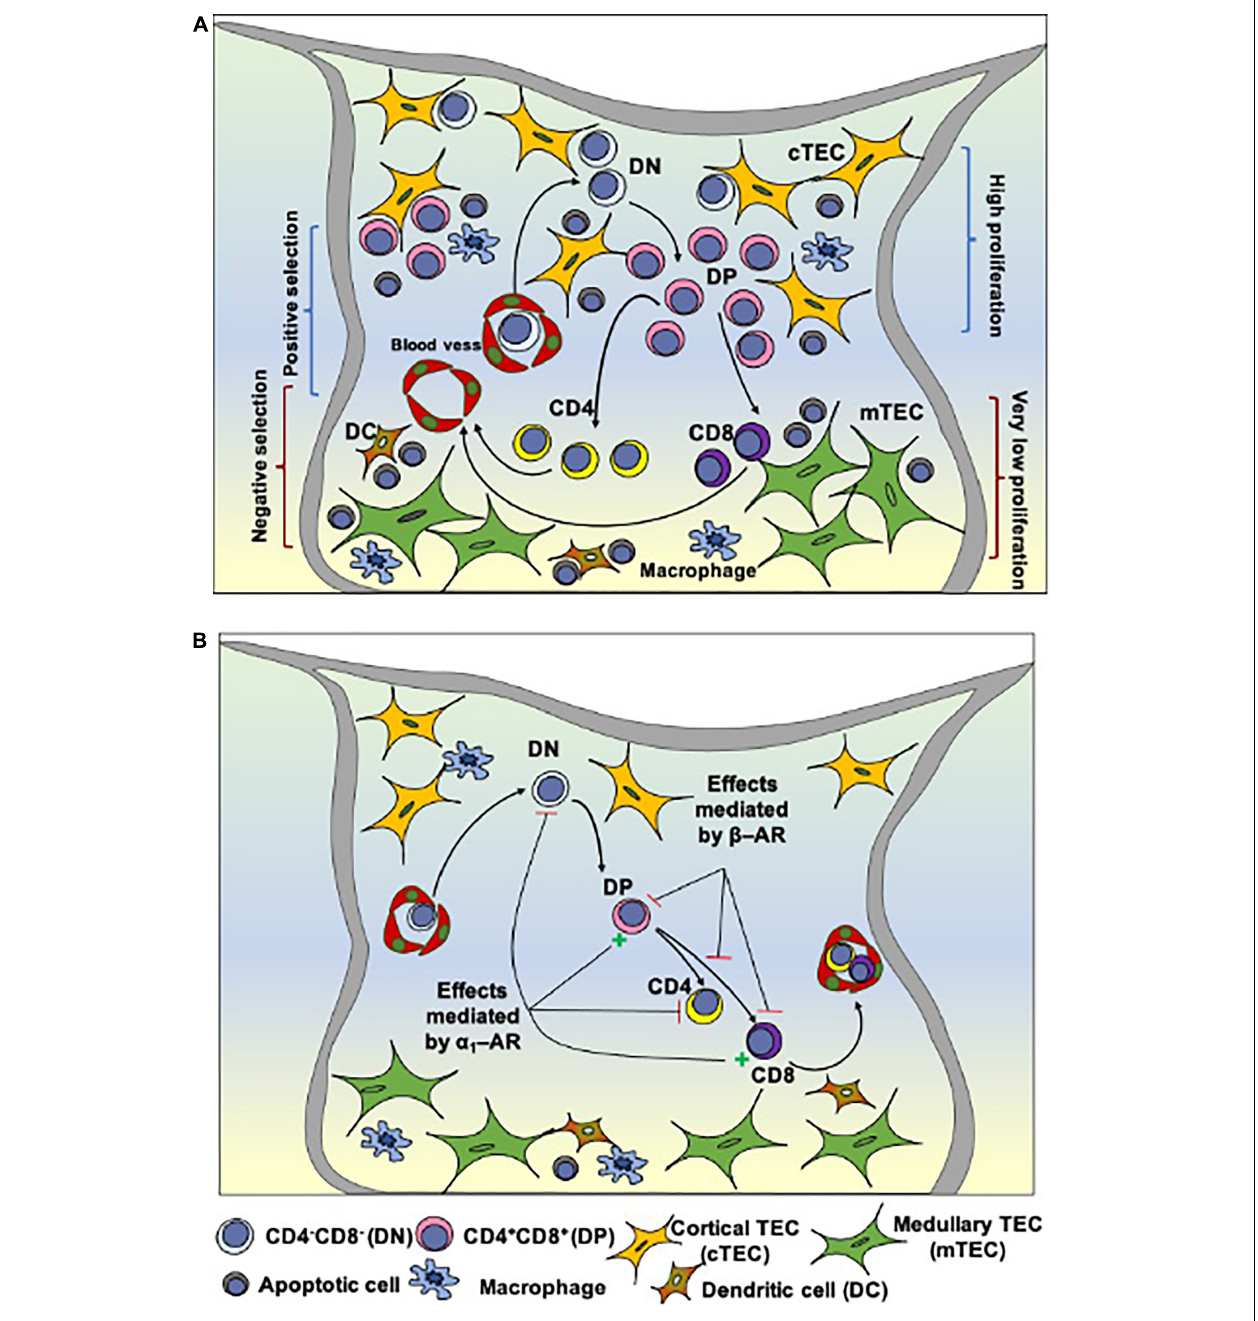
FIGURE 1 | Intrathymic T cell differentiation within the thymic microenvironment and stages that can be modulated by norepinephrine. (A) Shows schematically the general process of thymocyte differentiation, in the context of the thymic microenvironment. Bone marrow-derived precursors enter the organ through capillaries at the corticomedullary junction and migrate toward the outer cortex where they proliferate, but do not express the CD3/TCR complexes as well as the accessory molecules CD4 and CD8. There CD4/CD8 double-negative cells (DN) evolve to express TCR as well as CD4 and CD8 (becoming double-positive cells, DP) and, under the control of the thymic microenvironment, undergo positive selection, with positively-selected thymocytes migrating toward the medulla, where some of them will die by negative selection. Mature CD4 or CD8 single-positive thymocytes will eventually leave the thymus. (B) Depicts the influence of α and β -adrenergic receptors (AR) along with thymocyte differentiation in the rat thymus. Activation of α 1-AR reduces the frequency of DN cells and increases DP cells. It is hypothesized that signaling through β -AR (via regulation of Thy-1 expression) modulates the selection process, reducing positive and/or increasing negative selection, and detains thymocyte differentiation, while α 1-AR signaling may prevent the differentiation of positively selected cells toward the CD4 + SP phenotype. Stellate yellow cells: cortical TECs; stellate green cells: medullary TECs; round cells with a purple nucleus: thymocytes in different stages of development; blue cells: macrophages; brown cells: dendritic cells (DCs). Reduction = – and increase = + Adapted from Leposavi´c et al. (2008) and Savino et al. (2015).